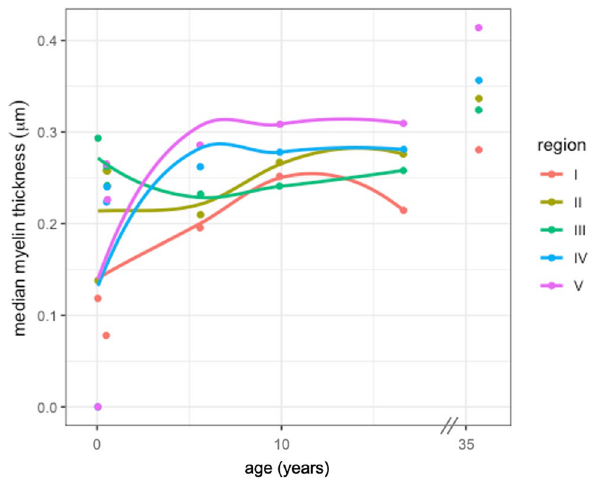
Figure 3. Scatterplot of median myelin thickness by age seperated by region. The lines were fit with LOESS regression. One subject (35.4 years) was excluded from LOESS regression.